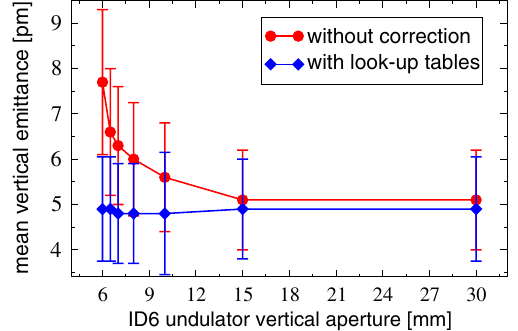
FIG. 8. Mean vertical emittance (cid:2) (cid:3) measured against the ver- y tical aperture of the ID6 in-vacuum undulator without any correction (red circles) and with automatic coupling compensa- tion (blue diamonds). Error bars corresponds to the spread (cid:2)(cid:3) y